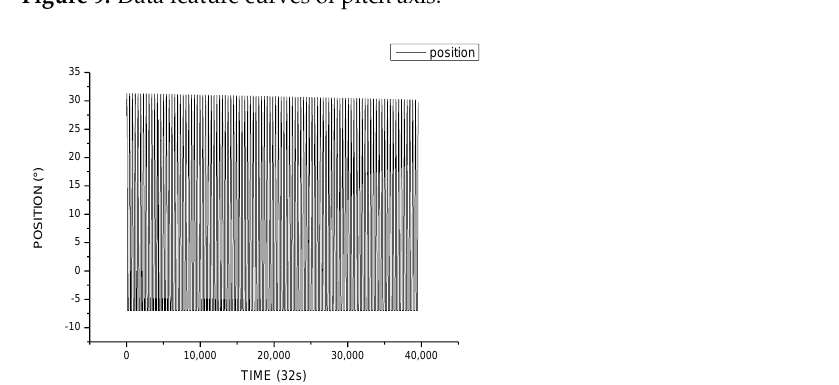
Figure 11. Loss curve for training set and test set.